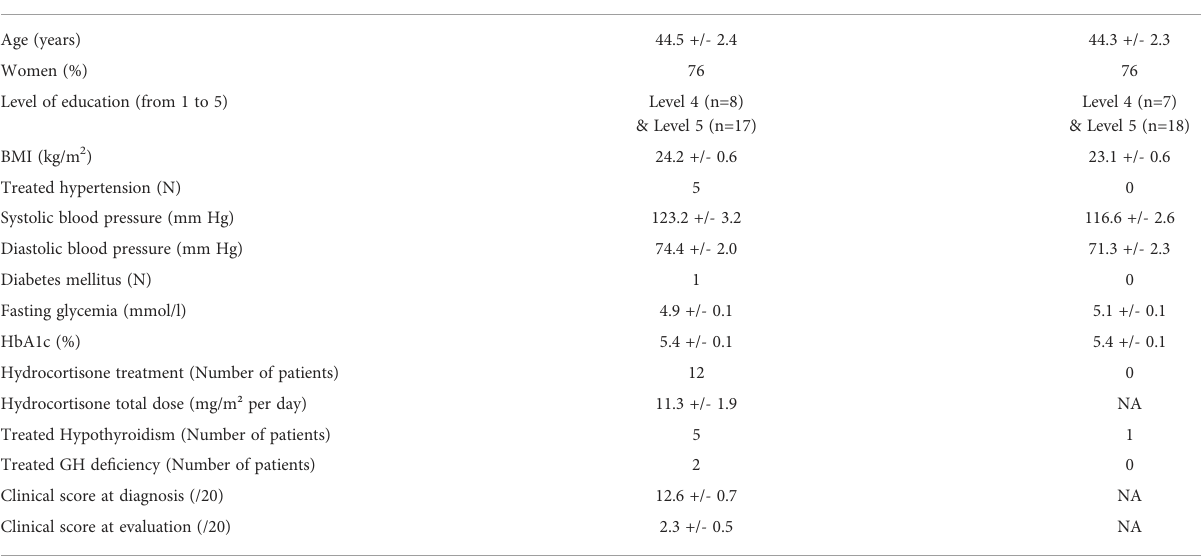
TABLE 1 Characteristics of participants in the Memocush